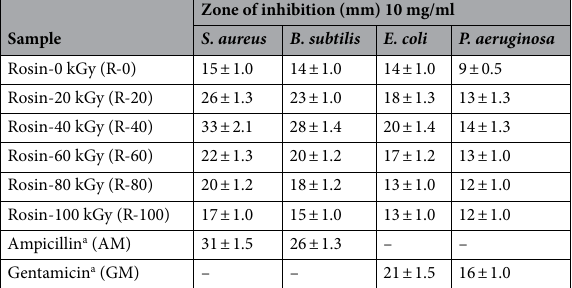
Zone of inhibition (mm) 10